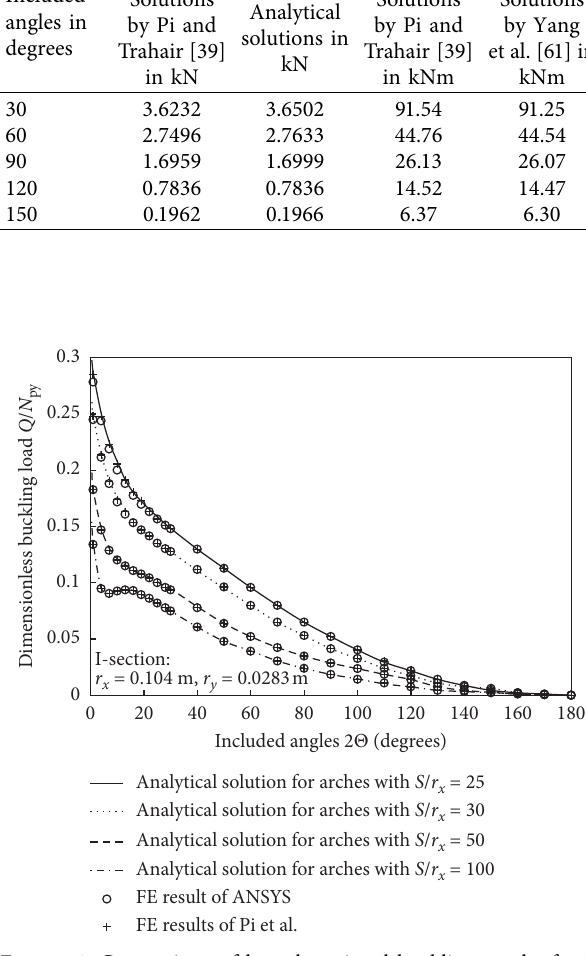
Figure 4: Comparison of lateral-torsional buckling results for I- section arches from different methods